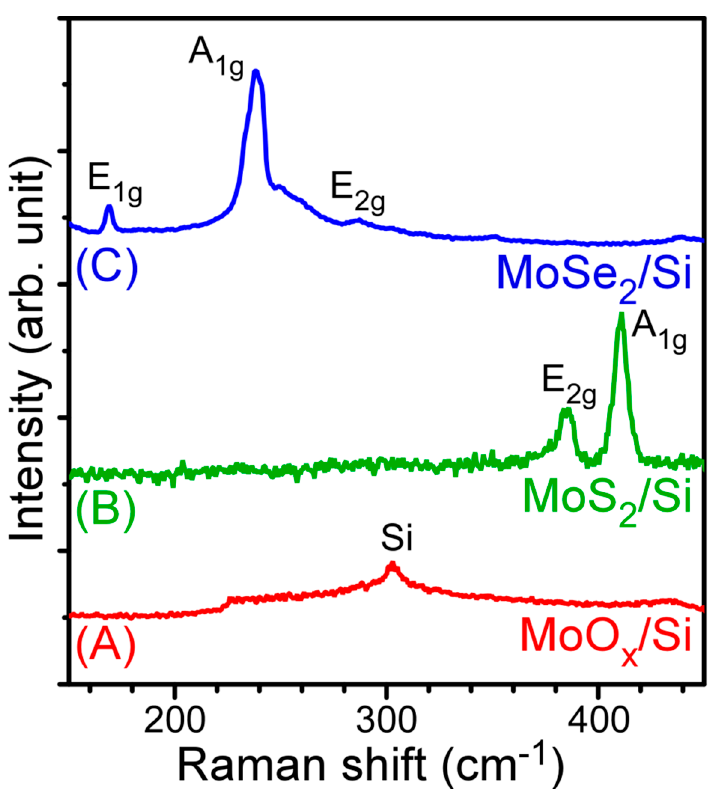
/ Si and (C) MoSe 2